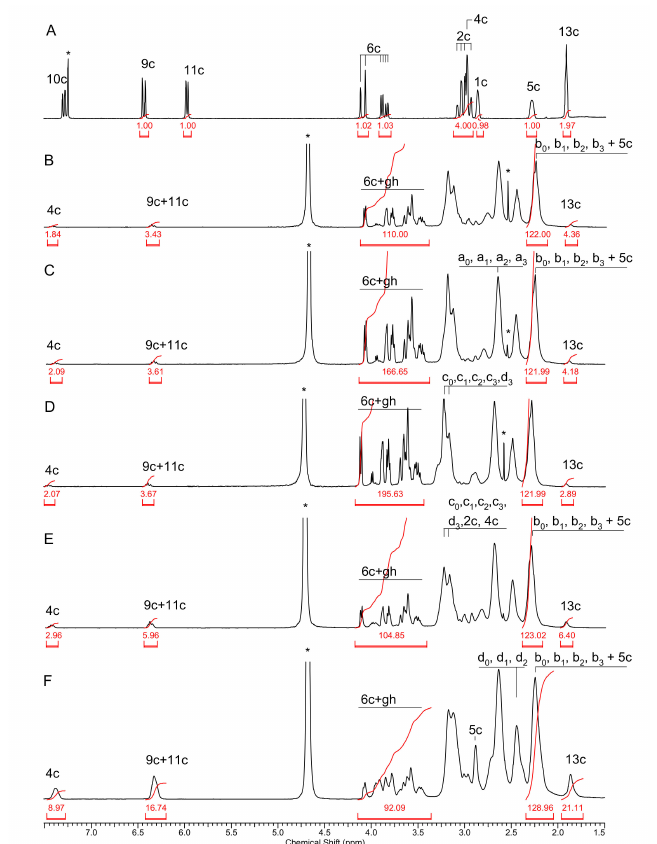
Figure 4. The 1 H-NMR spectra of C in CDCl 3 ( A ), G3 2C16gh ( B ), G3 2C23gh ( C ), G3 2C26gh ( D ), G3 3C14gh ( E ), and G3 9C11gh ( F ) in D 2 O: The resonances of C are labeled by atom number (see Figure 1)